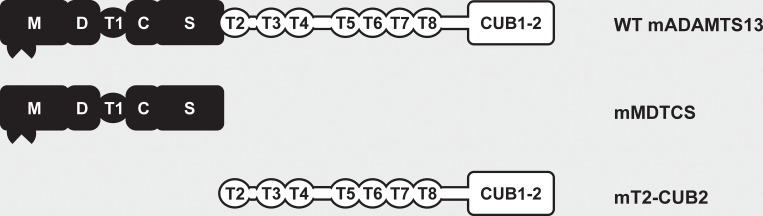
Schematic representation of the mADAMTS13 variants used in this study.The proximal (MDTCS) domains are represented in black and include a metalloprotease (M), disintegrin-like (D), thrombospondin type-1 repeat (T1), cysteine-rich (C) and spacer (S) domain. Distal (T2-CUB2) domains are represented in white and consist of seven thrombospondin type-1 repeats (T2 up to T8) and two CUB (Complement component C1r/C1s, Urinary epidermal growth factor (Uegf) and Bone morphogenic protein-1) domains.